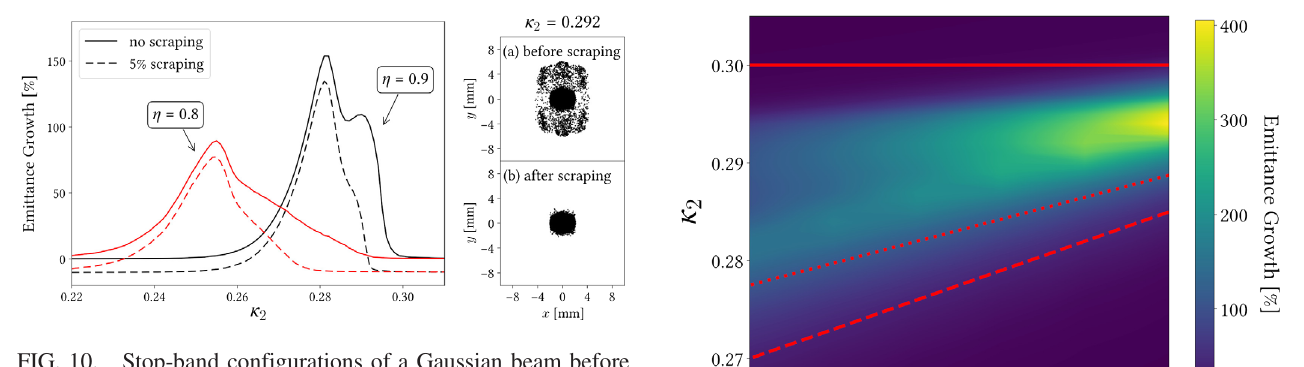
FIG. 10. Stop-band configurations of a Gaussian beam before and after halo scraping. The stop band at the 200th sinusoidal cell in Fig. 9 is replotted with a solid line for comparison. The dashed line indicates the band profile after 5% of tail particles with large oscillation amplitudes in phase space are scraped off. The final cross-sectional views of the beam at κ 2 ¼ 0 . 292 ( η ¼ 0 . 9 ) before and after the scraping are shown in the right panels.